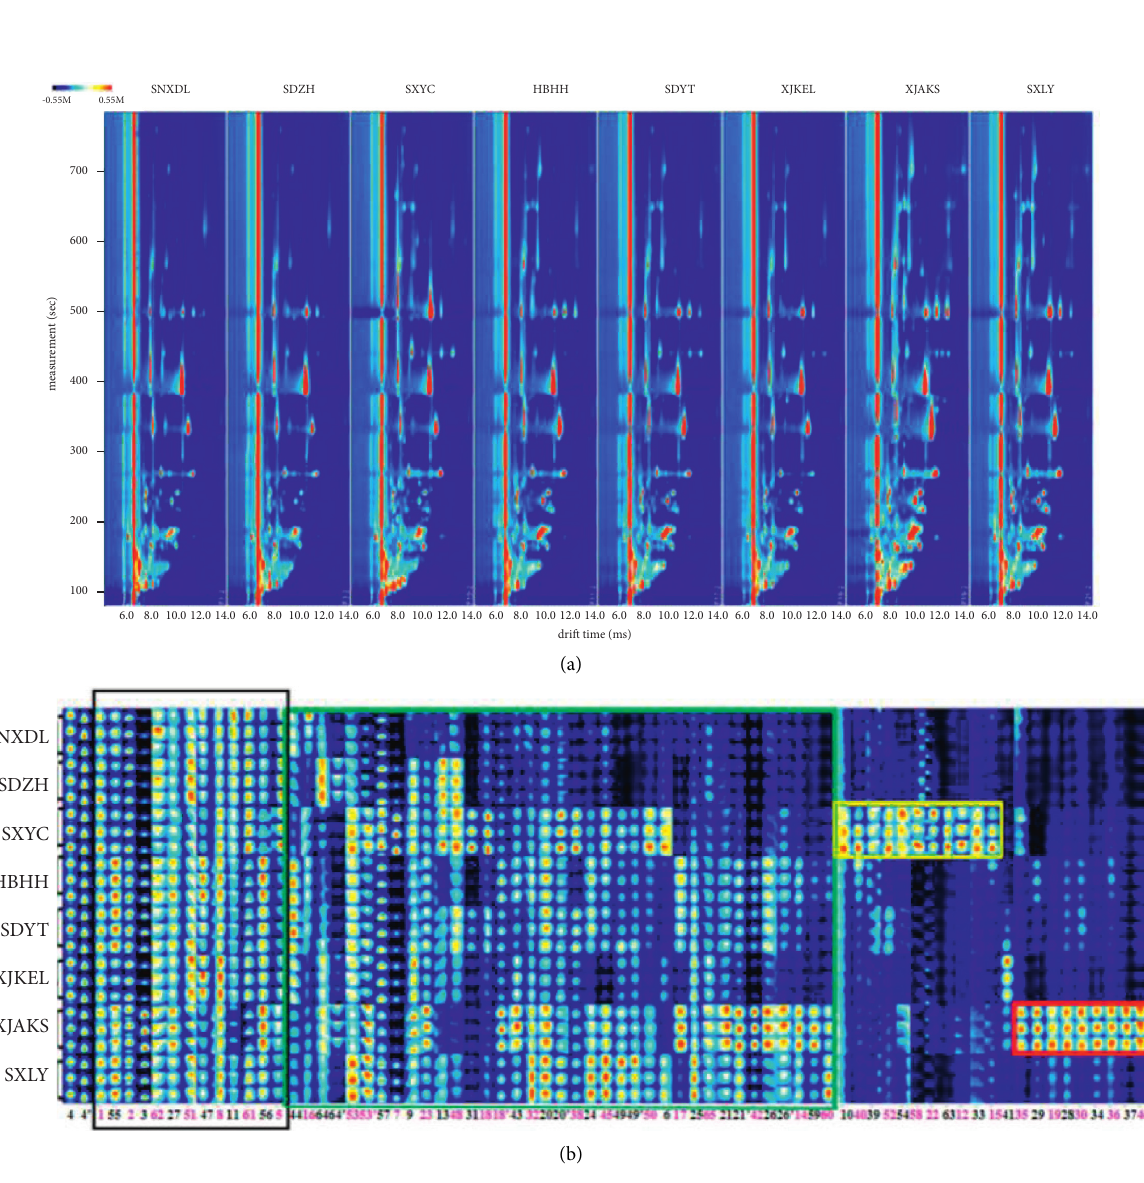
Figure 1: (a) 2D topographic plots of VOCs from eight regions of winter jujube. (b) VOCs qualitative comparisons of eight regions of winter jujube by